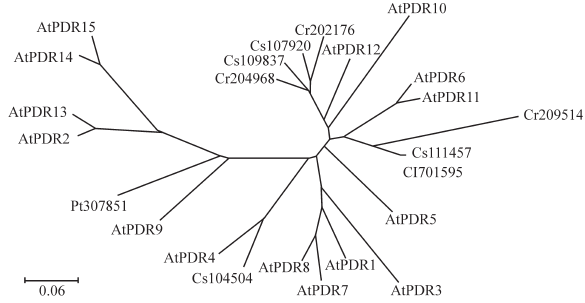
Figure 3 - Phylogenetic interrelationships of nine predicted PDR-like transporters identified in citrus species and 15 PDR-like representatives from A. thaliana . The unrooted tree was constructed by the MEGA 3.1 software (Kumar et al. , 2004), according to the minimum evolution method (Rzhetsky and Nei, 1993) with 1,000 bootstrap replicate trees, based on a preliminary neighbor - joining tree (Saitou and Nei, 1987). The scale bar represents the number of nucleotide substitutions per